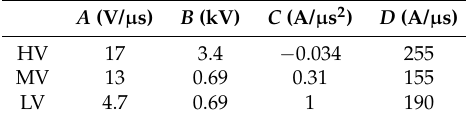
Table 1. Typical parameters of A , B , C and D . HV: high voltage; MV: medium voltage; LV: low